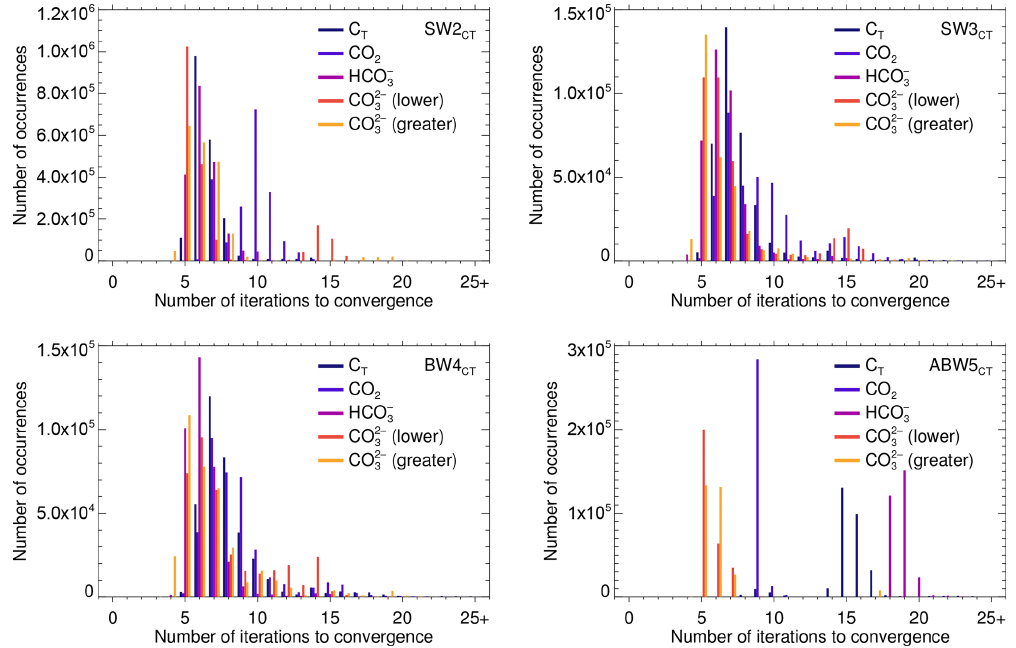
Figure 7. Number of iterations to convergence required by the various data pairs (separately for the lower and the greater [H + ] roots of the Alk T –CO 2 − problem), for each of the four test cases, carried out with solve_at_general_sec (using a hybrid secant–regula falsi– 3 bisection method). The absolute maximum numbers of iterations were respectively 20, 21, 29 and 27, for SW2, SW3, BW4 and ABW5, respectively, and 20 for SW1 (not